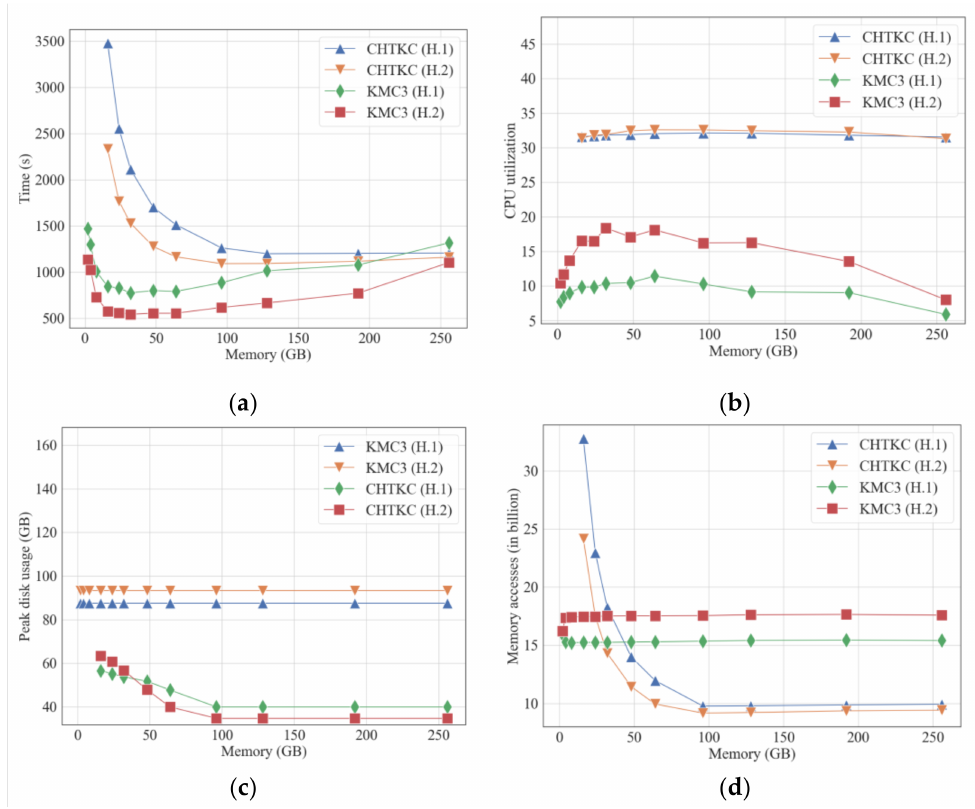
Figure 1. Comparison of KMC3 and CHTKC with various memory limits for counting 32-mer in H.1 and H.2. ( a ) running time; ( b ) CPU utilization rate; ( c ) peak disk consumption; ( d ) memory access